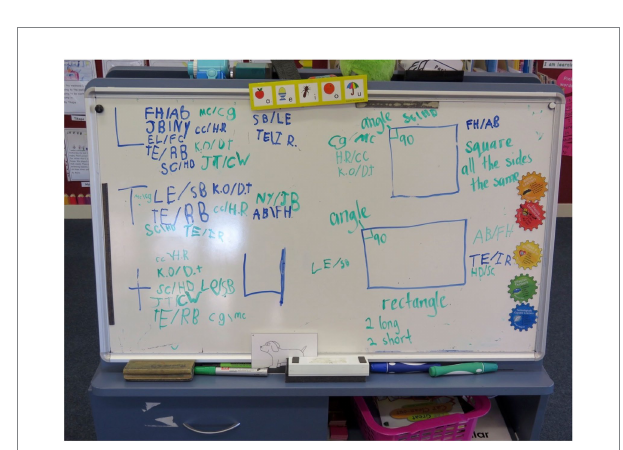
FIGURE 3 Students’ procedures were checked and results recorded on the whiteboard for assessment